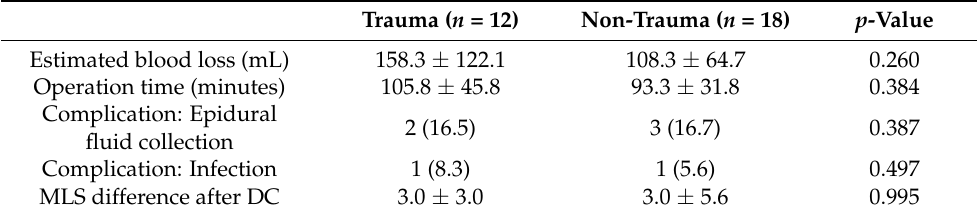
Table 6. Comparison of results in trauma and non-trauma in Group